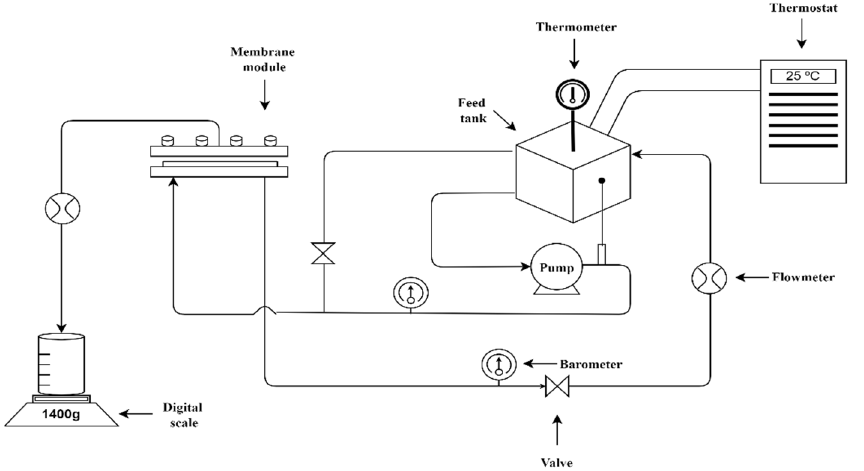
Figure 1. Schema of membrane test cell (model OS-MC-01).